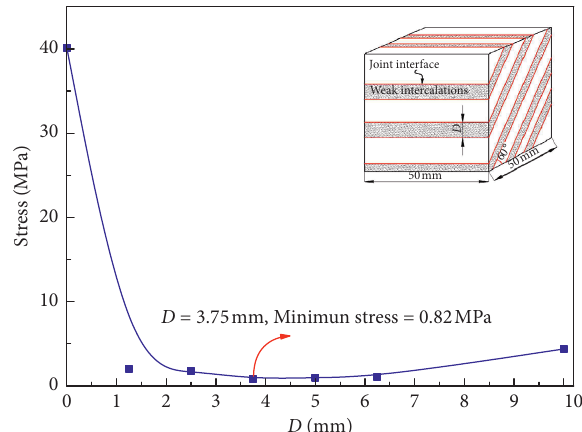
Figure 13: Stress-strain curve of CJB with different joint thickness.